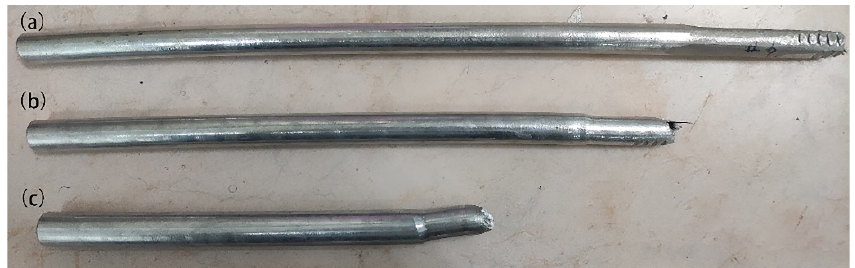
Figure 9. Sample after drawing: ( a ) Ø15 mm; ( b ) Ø16 mm; ( c ) Ø18 mm.